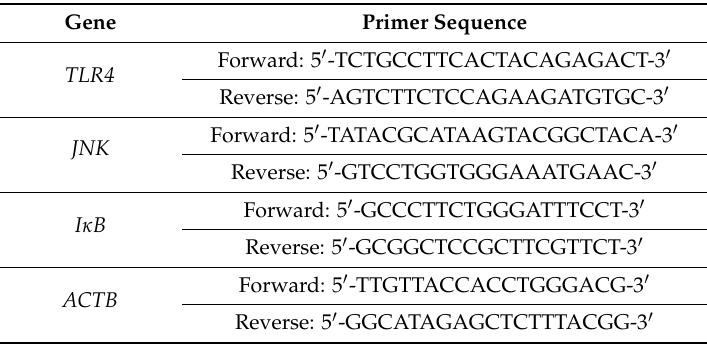
Table 1. Primer sequences for real-time